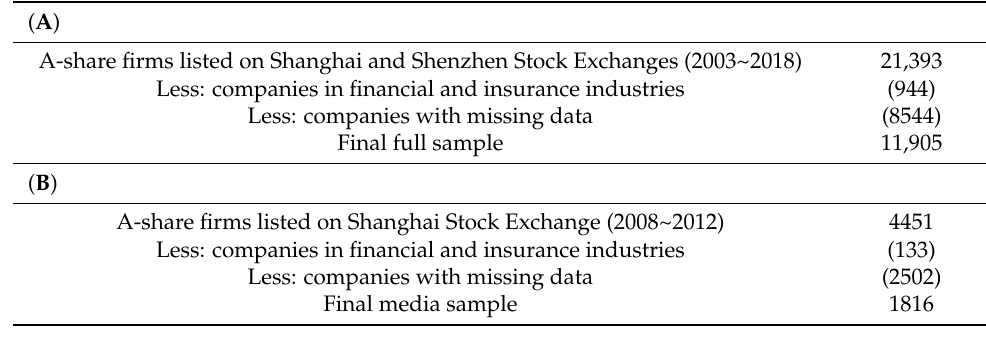
Table 1. Sample Selection Process. Panel ( A ) Full Sample. Panel ( B ) Media